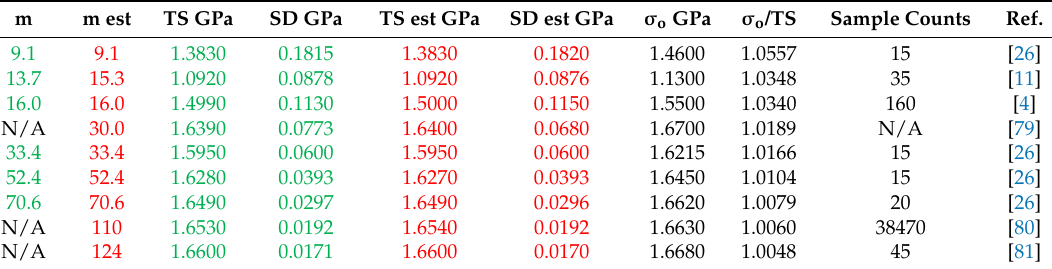
Table A1. Input data and results of Weibull